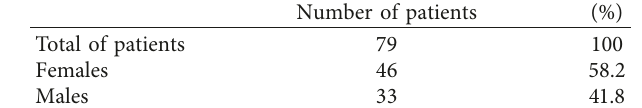
Clinical findings